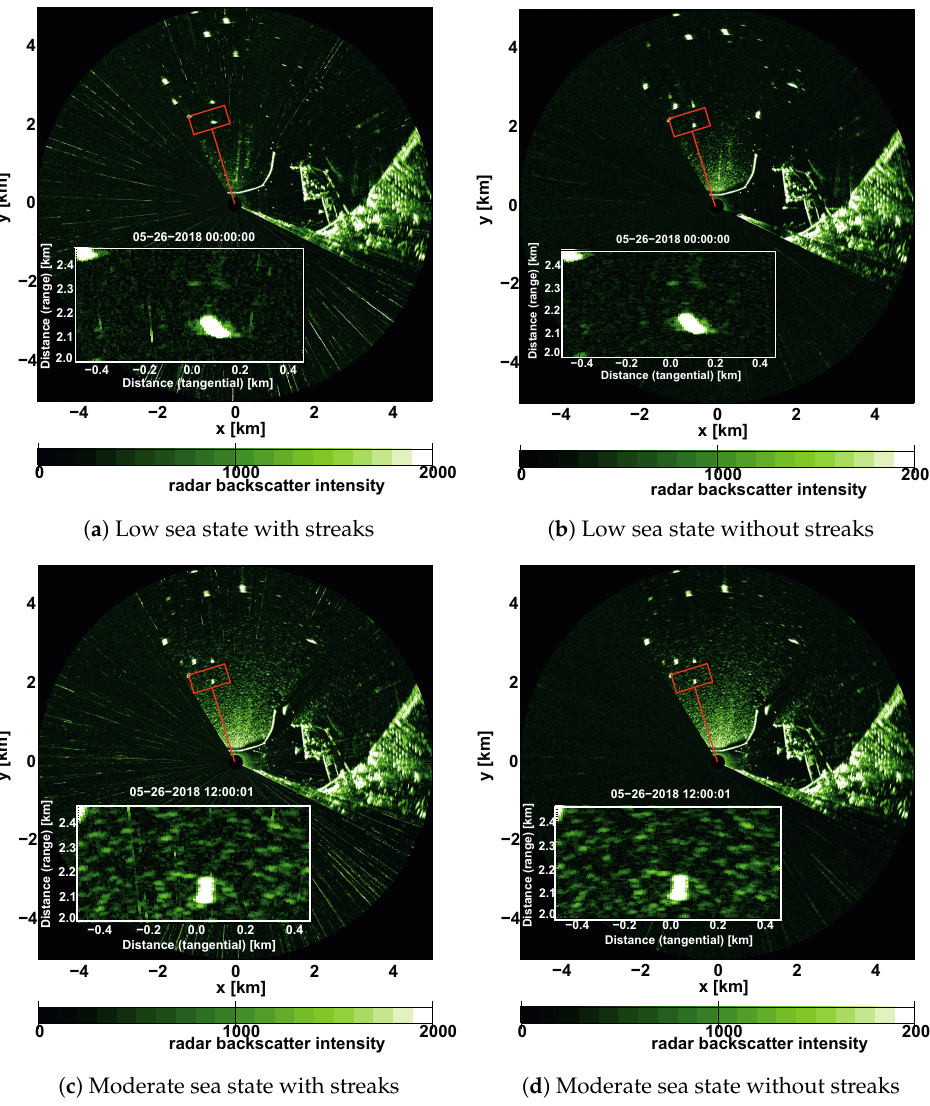
Figure 2. Examples of the WaMoSII X-Band radar images of a low ( H s ≈ 0.6 m, wind speed 3.2 m/s) and moderate sea states ( H s ≈ 1 m, wind speed 5.8 m/s), acquired at Haifa port given before (left column) and after (right column) streak filtration procedure application. Zoomed areas correspond to the analysis area of box 1 (red rectangle). Ships are clearly visible as a bright spots within the radar